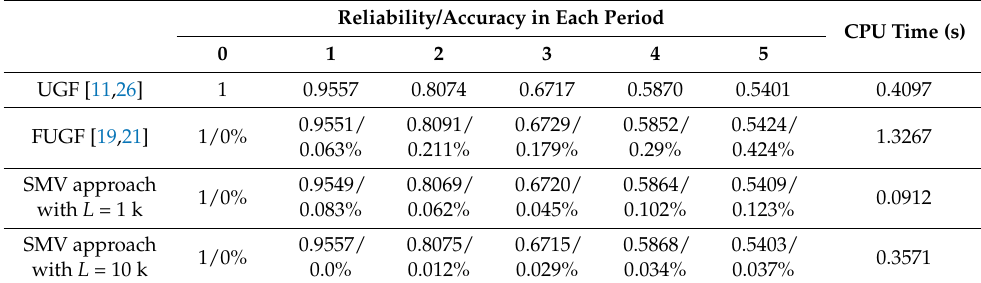
Table 8. The reliability and accuracy of a dynamic system of mode I in each period using UGF, FUGF, and SMV methods; L : The sequence length for the SMV approach.